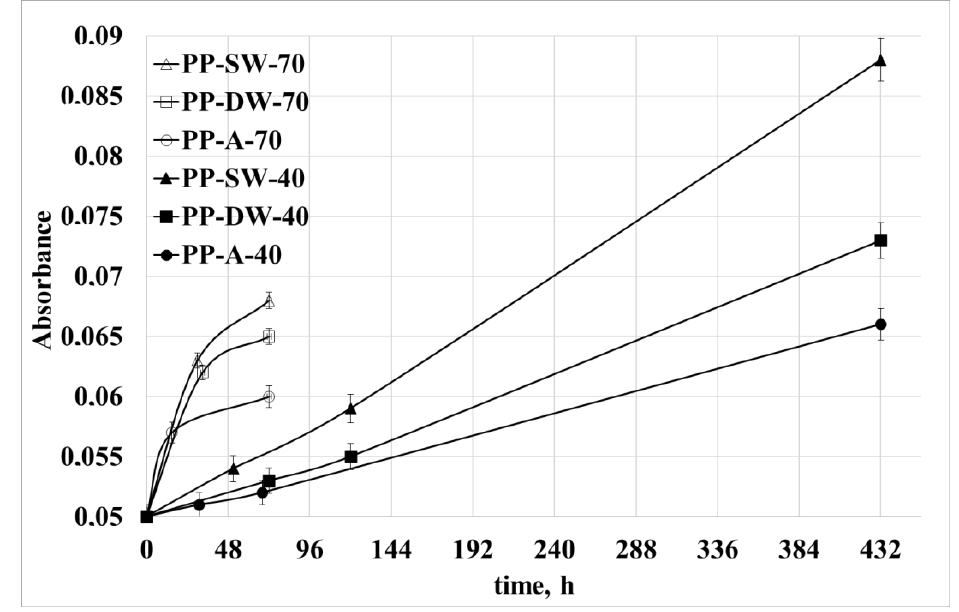
Figure 6. Peak height at 888 cm − 1 at 40 °C and 70 °C.